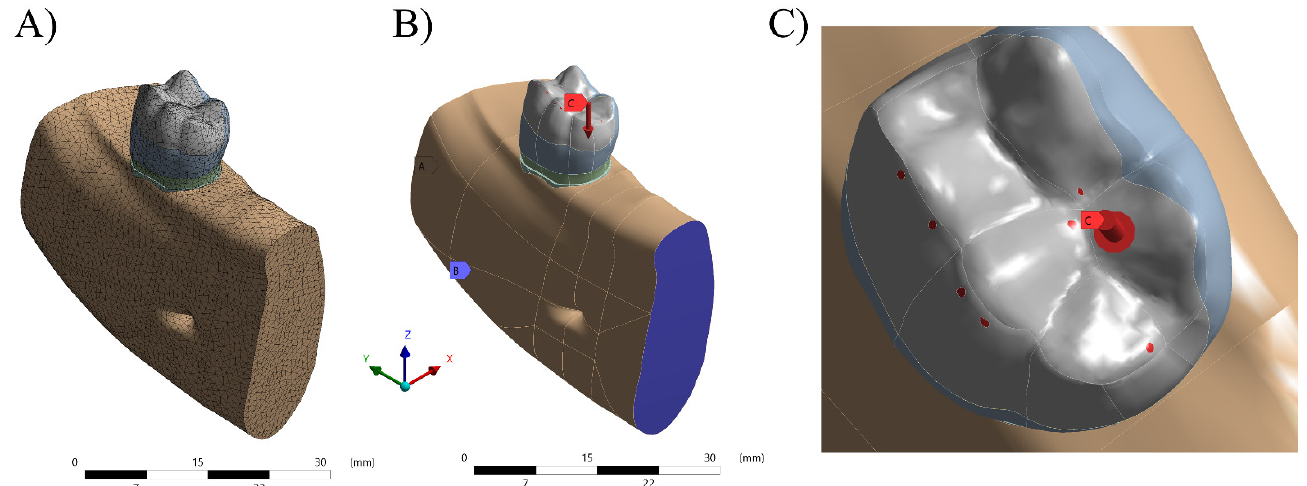
Figure 1. Numerical model processing. ( A ) Mesh generation. ( B ) Fixation of the system. ( C ) Axial load application in occlusal points.